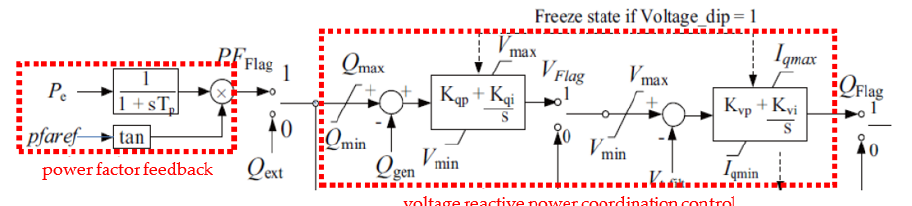
Figure 6. The power factor feedback and voltage reactive power coordination control block diagrams of the REEC .